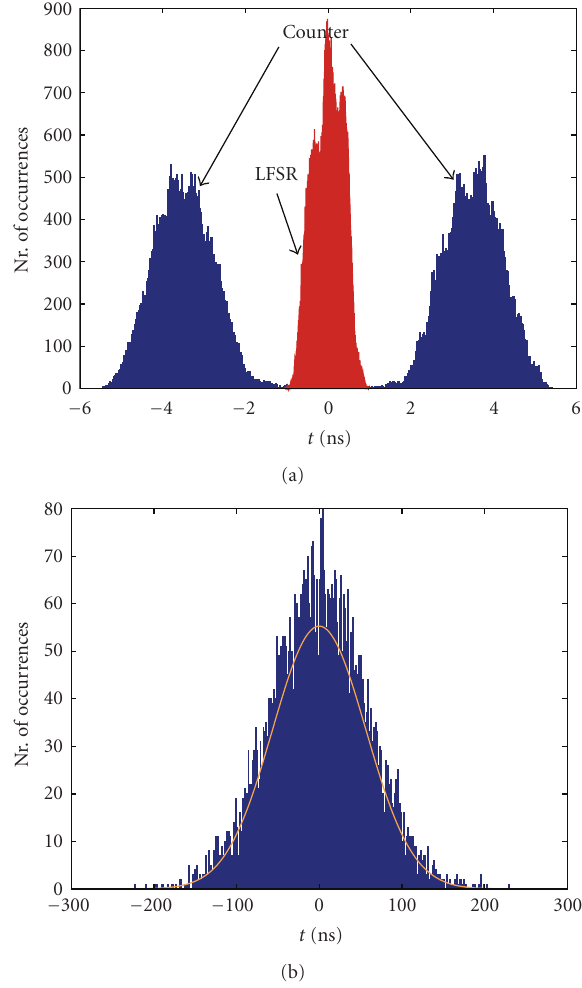
Figure 7: Execution period C2C jitter of 16-bit counter and LFSR (a), C2C jitter histogram of counting periods of 16-bit counter